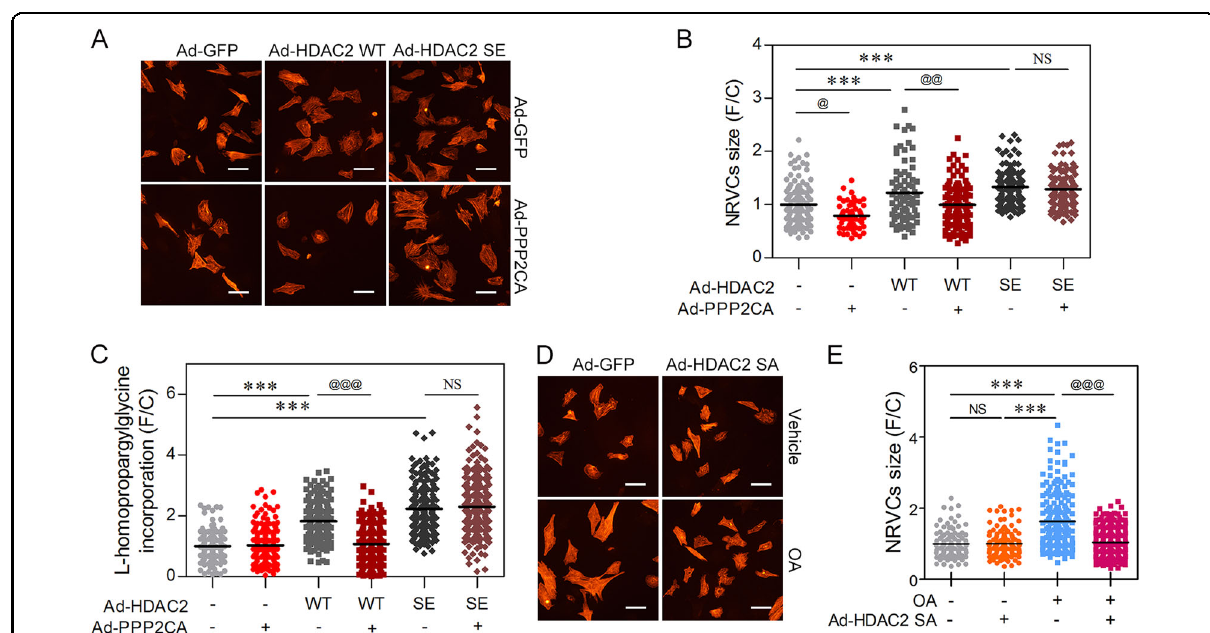
Fig. 6 PPP2CA targets S394 phosphorylation of HDAC2 to modulate its hypertrophic signal. a , b Cell size measurements were performed in NRVCs infected with either Ad-HDAC2 wild-type (WT) or Ad-HDAC2 SE, phosphomimic mutant (SE indicates HDAC2 S394E). Both Ad-HDAC2 WT and Ad-HDAC2 SE successfully induced cardiomyocyte hypertrophy ( b , 3rd and 5th group). Ad-PPP2CA abolished Ad-HDAC2 WT-driven cell enlargement. Ad-PPP2CA, however, failed to do so when Ad-HDAC2 SE was infected ( b ). c Quanti fi cation of HPG incorporation. NRVCs were infected with Ad- HDAC2 WT, SE, or Ad-PPP2CA for 48 h. Similar to 5 A and 5B, Ad-PPP2CA failed to suppress Ad-HDAC2 SE-driven cardiomyocyte hypertrophy. d , e OA- mediated hypertrophy was signi fi cantly attenuated by infection of Ad-HDAC2 SA, a phospho-resistant mutant of HDAC2 (SA indicates HDAC2 S394A). OA itself induced cardiomyocyte hypertrophy, which was signi fi cantly blunted when Ad-HDAC2 SA was infected. PPP2CA targets HDAC2 S394 phosphorylation for its negative regulation of cardiac hypertrophy. White solid bars depict 15 μ m. @ indicates p < 0.05. @@ means p < 0.01. *** and @@@ indicate p < 0.001. NS not signi fi